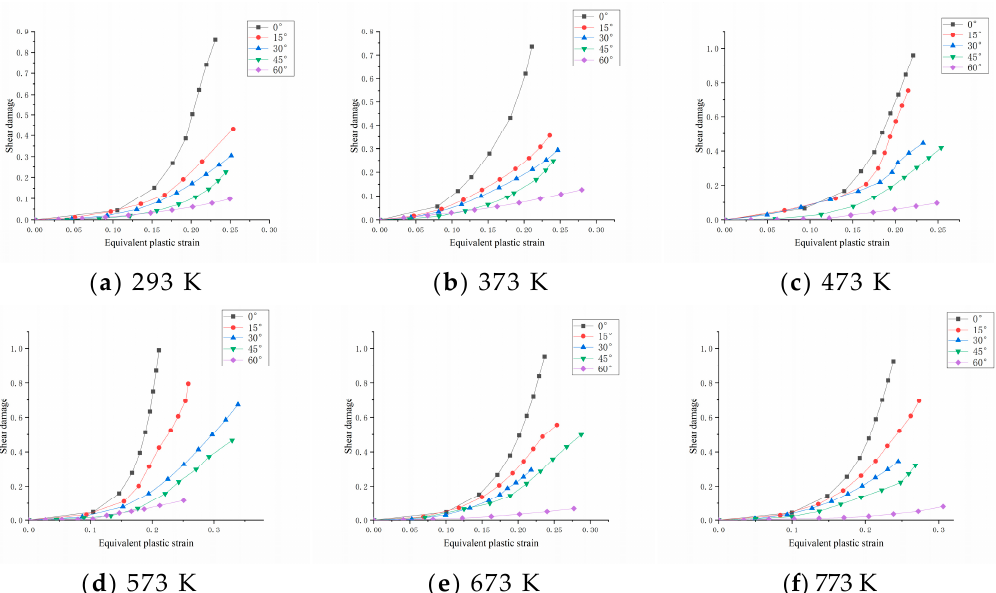
Figure 18. VVF and equivalent plastic strain diagram at different temperatures ( a – f ).